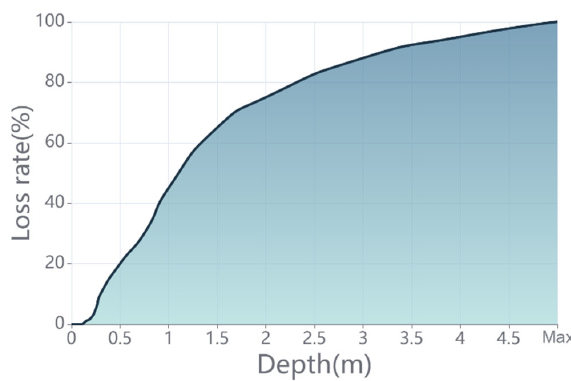
Figure 4. Stage–damage curves for building ‐ material ‐ based vulnerability.